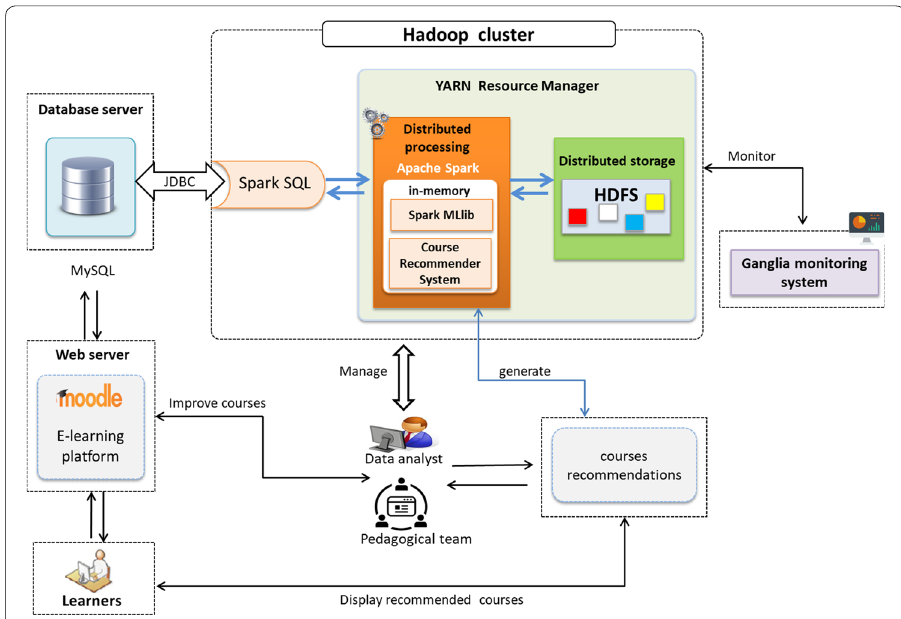
Fig. 5 Course recommender system architecture: It describes different steps and framework used within the recommendation